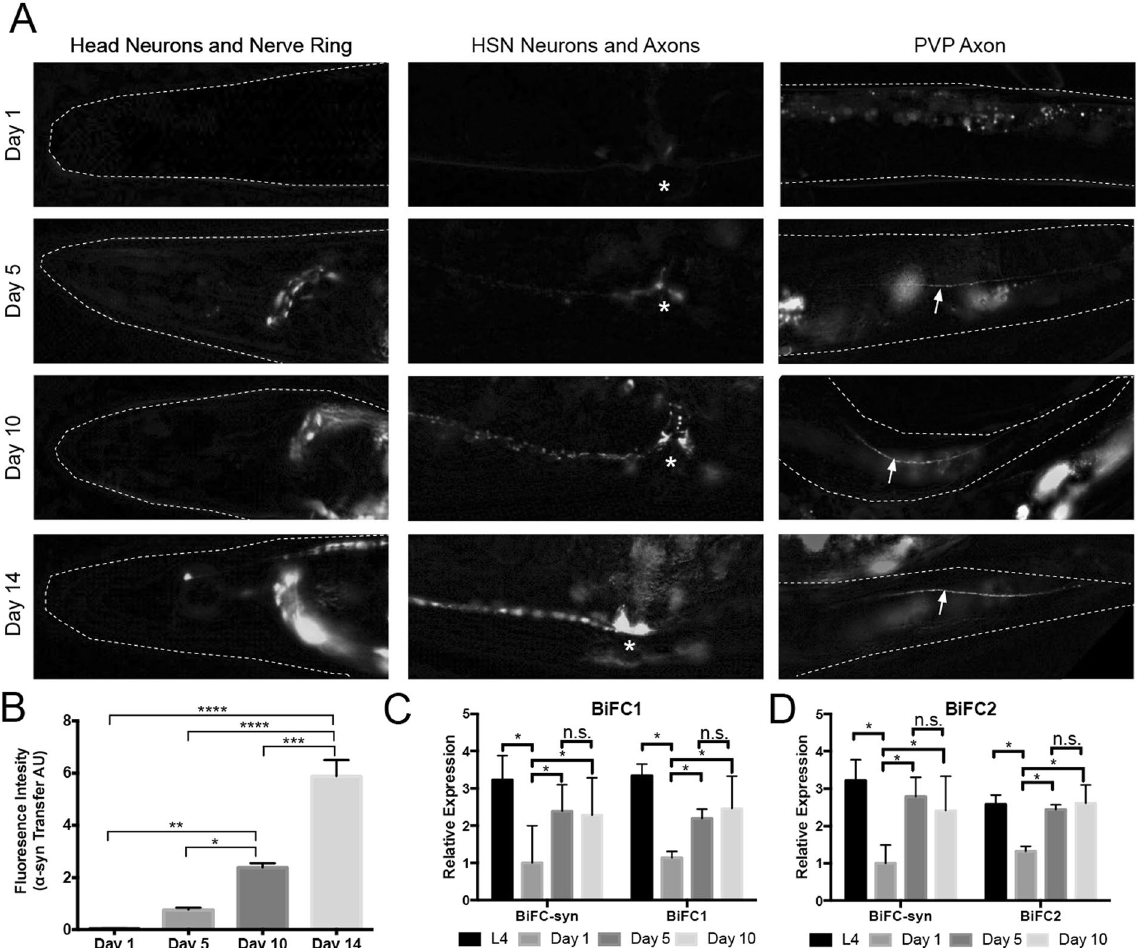
Figure 3. BiFC-syn C. elegans model reveals neuron-to-neuron transfer that increases with age. ( A ) BiFC- induced expression of EGFP detected in the head region and nerve ring, the HSN neurons and axon and the PVP axon in the tail region of the worm in 1, 5, 10 and 14 days old BiFC-syn worms. * Denotes location of vulva. ( B ) Quantification of the fluorescence intensity in the nerve ring and head region of 1, 5, 10 and 14 days old worms. Statistical significance was determined from the mean values of three independent experiments with at least 75 worms per group, using ANOVA in conjunction with a Tukey’s post-hoc multiple comparisons test (alpha = 0.05) ( C ) Relative mRNA levels of the BiFC1 construct in BiFC-syn worms and control worms expressing only the BiFC1 construct in L4, 1, 5 and 10 days old worms. ( D ) Relative mRNA levels of the BiFC2 construct in BiFC- syn worms and control worms expressing only the BiFC2 construct in L4, 1, 5 and 10 days old worms. Statistical significance was determined from the mean values of three independent qPCR experiments using ANOVA in conjunction with a Tukey’s post-hoc multiple comparisons test (alpha = 0.05). In all cases data is represented as mean of 3 independent experiment, represented as mean ± SEM. See also supplementary video